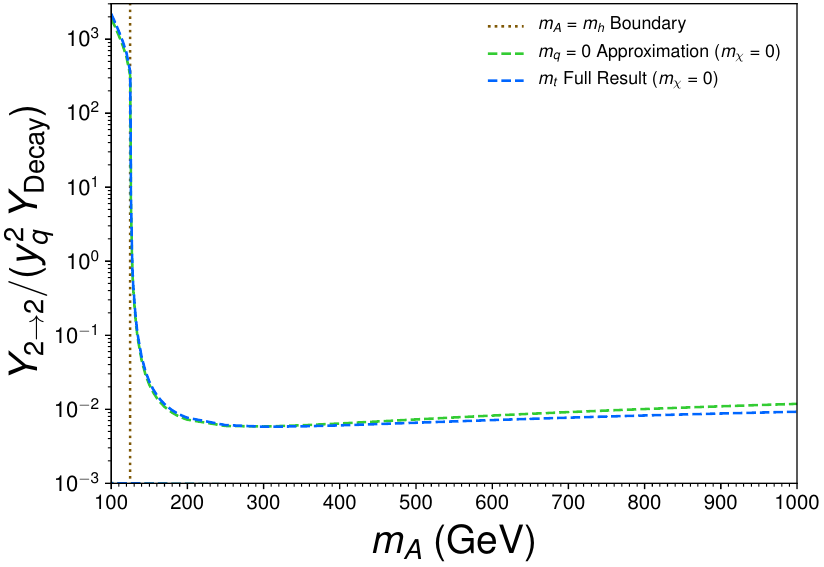
Figure 12 . Ratio of decays (1 production processes Y 2 ! 2 = ( y 2 and including the full m decay cannot happen) is shown as a brown dotted vertical